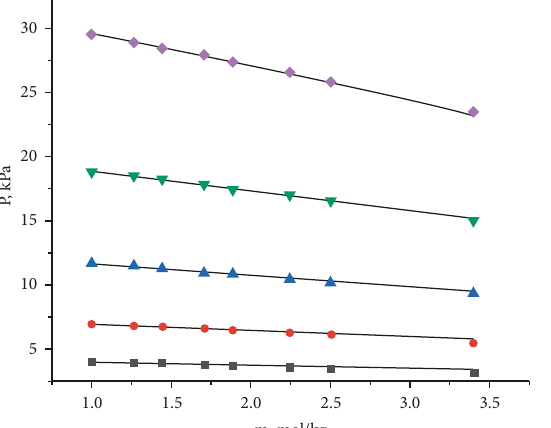
Figure 8: Calculation of the VLE for the BaBr2+H2O system. Symbols ( , T � 303.15K; , T � 313.15K; , T � 323.15K; , T � 333.15K; and , T � 343.15K :); VLE data; lines: